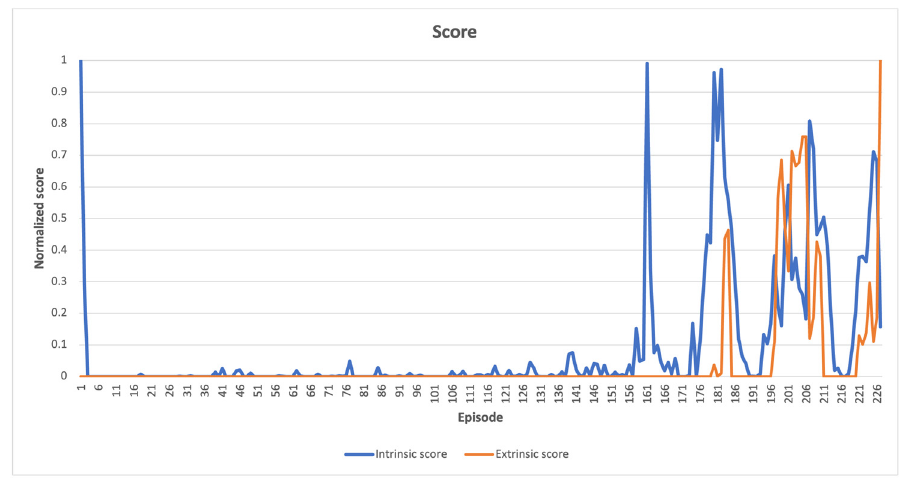
Figure 8. MountainCar-v0 learning scores, as the learning process progresses, newly explored states near the completion of the task yield high scores for both types of measurements.